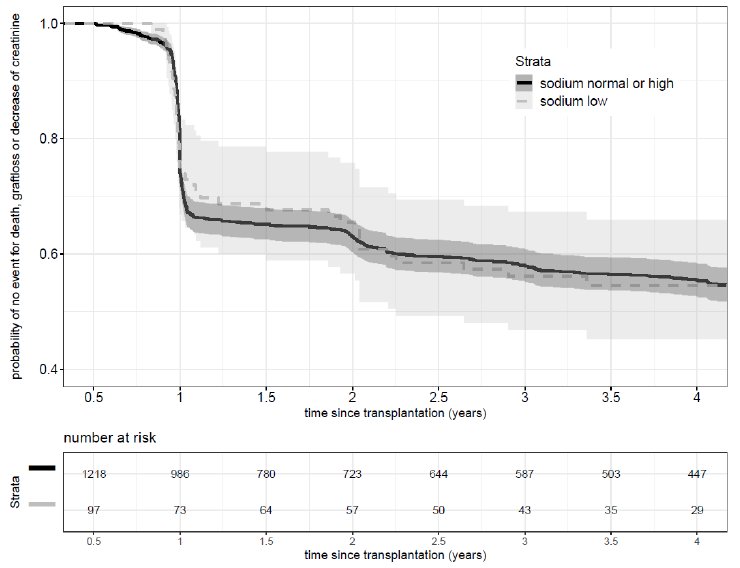
Figure 3. Kaplan Meier curve of composite outcome of death, graft loss or rapid decline of renal function by sodium level.